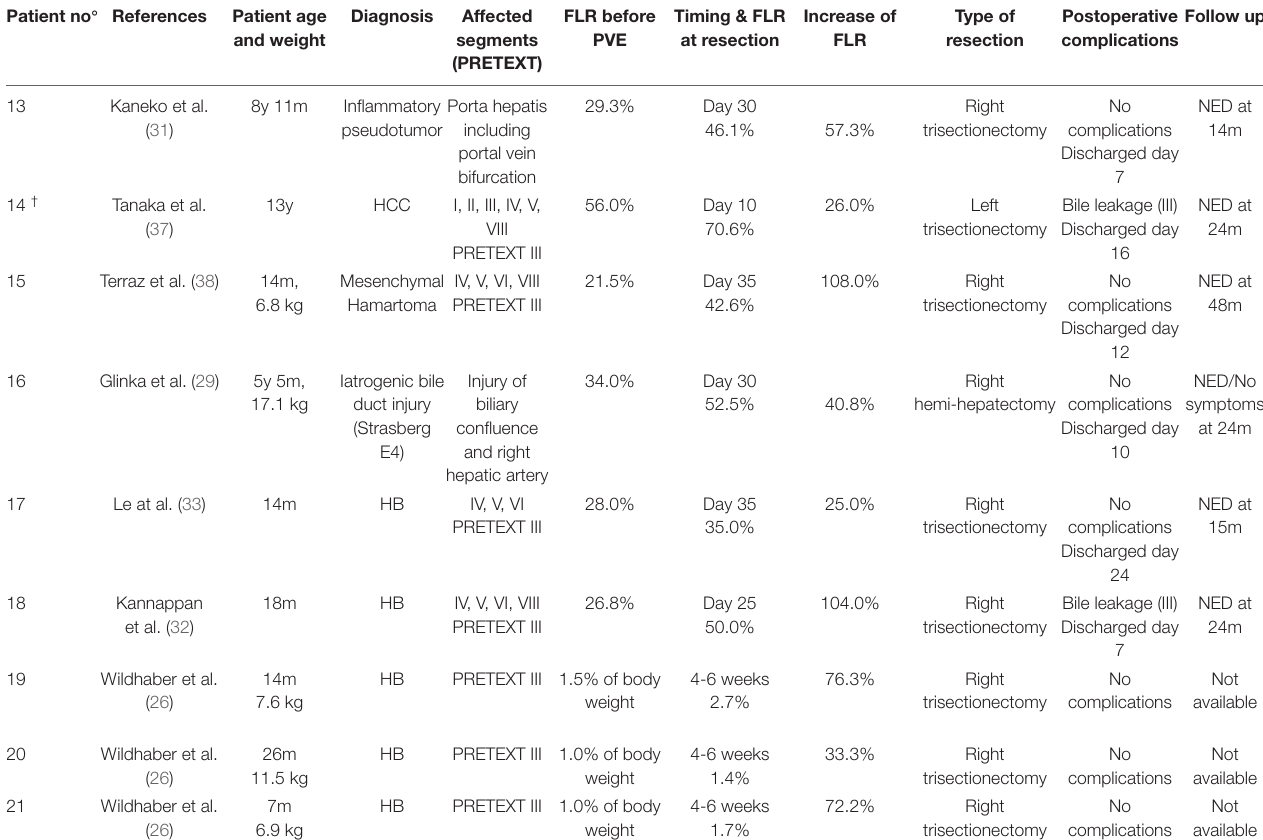
TABLE 3 | Overview of pediatric patients undergoing